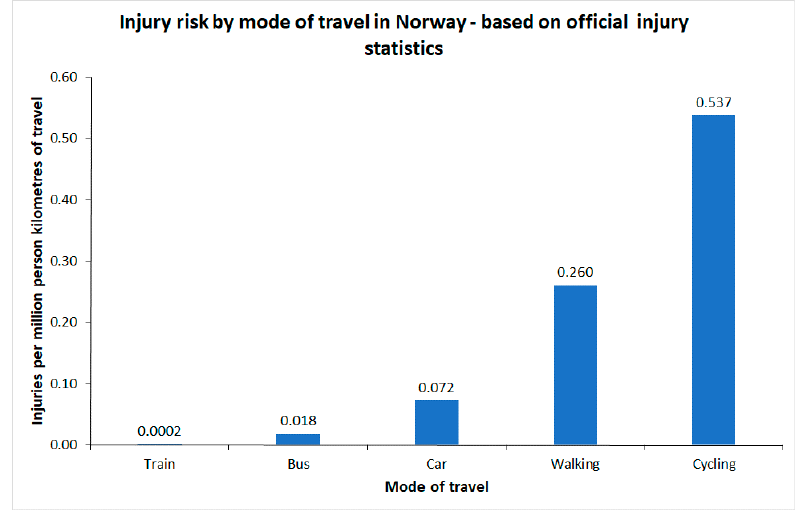
Figure 1. Injury risk by mode of travel in Norway, based on official injury statistics.